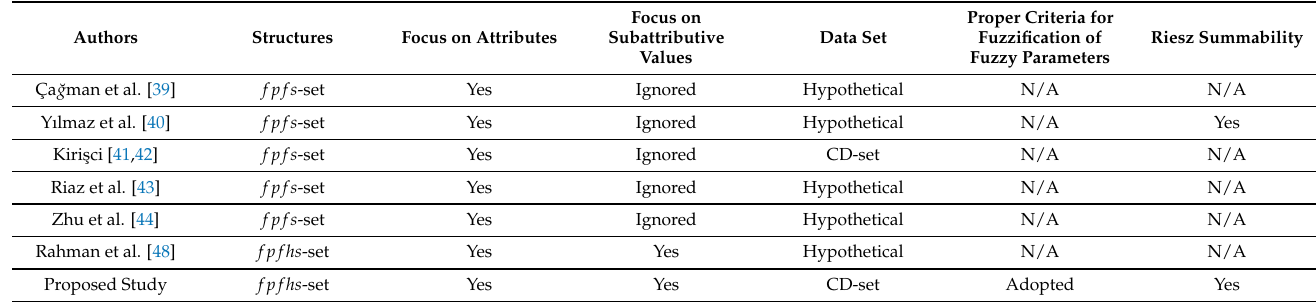
Table 10. Structural analysis of presented structure with pre-developed approaches.